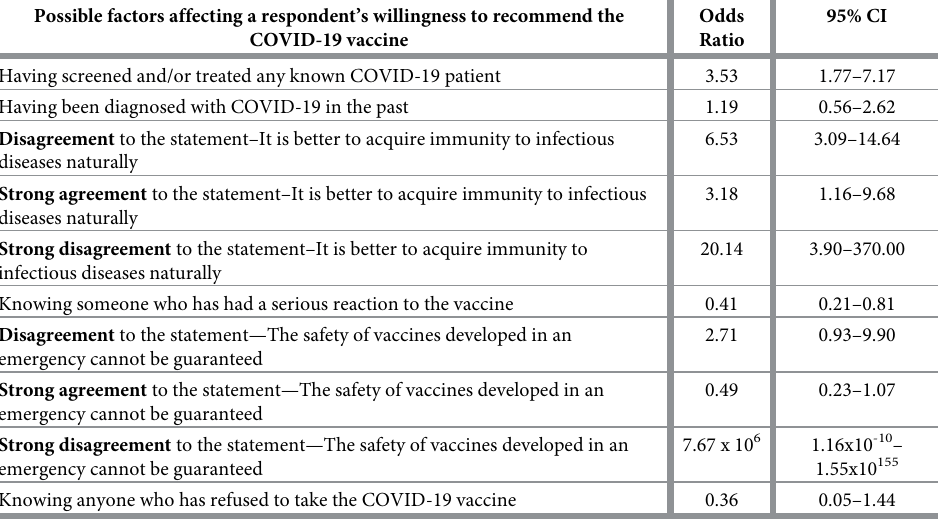
Table 5. Effects of non-demographic factors on our survey respondents’ willingness to recommend the COVID- 19